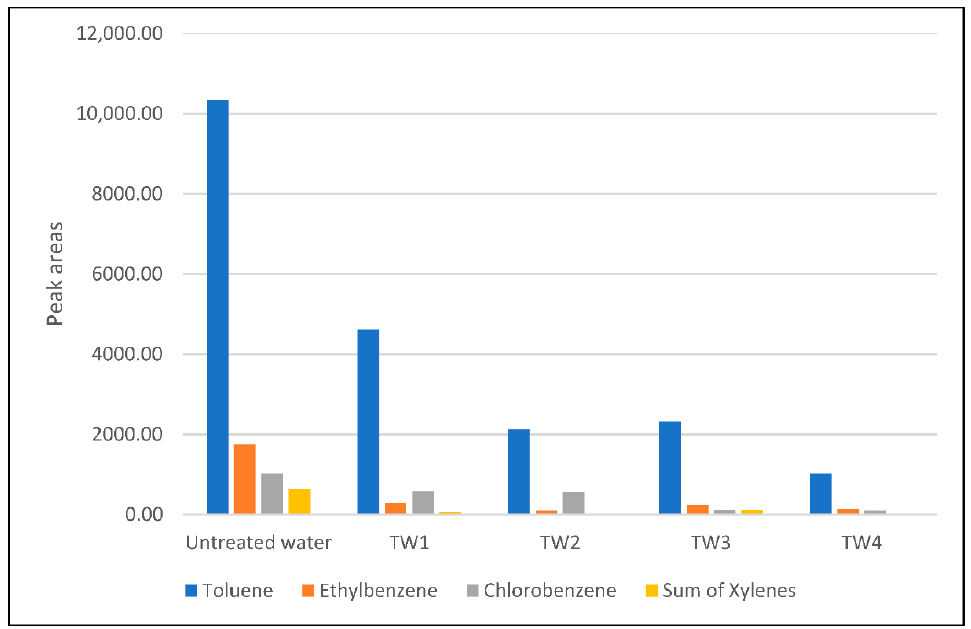
Figure 4. Dependence of the peak areas of studied VOCs on different treatment processes (TW 1—TW 4—treated water samples under the treatment conditions noted in Table 3).